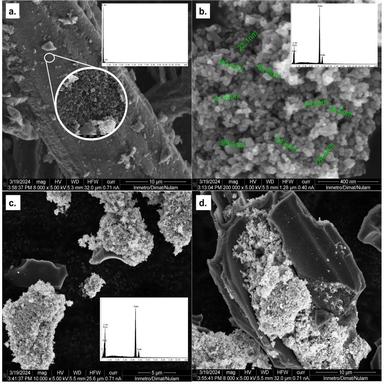
SEM images and EDX spectrums of the AC-541 (a), TiO2-541 (b), and TiO2/AC15%-541 (c–d).